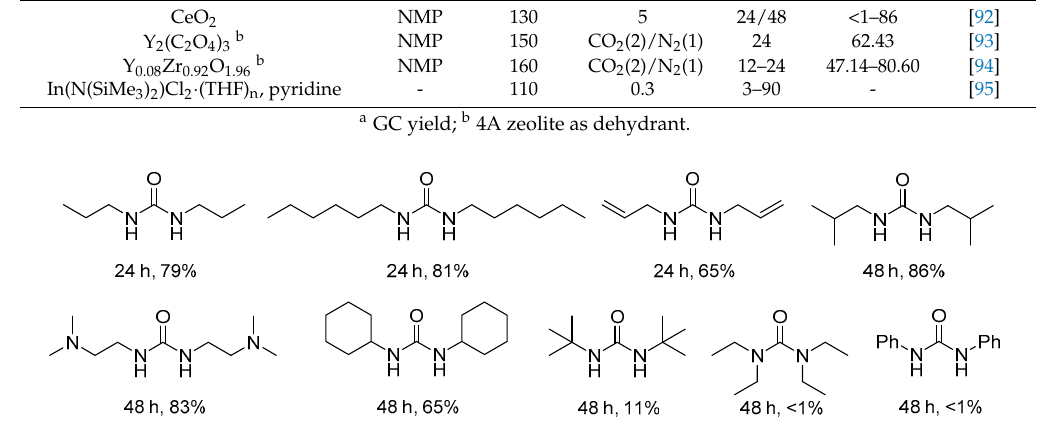
Figure 5. Various ureas by CeO 2 /NMP system. Reprinted with permission from [92] (Copyright 2015 Elsevier Inc.).